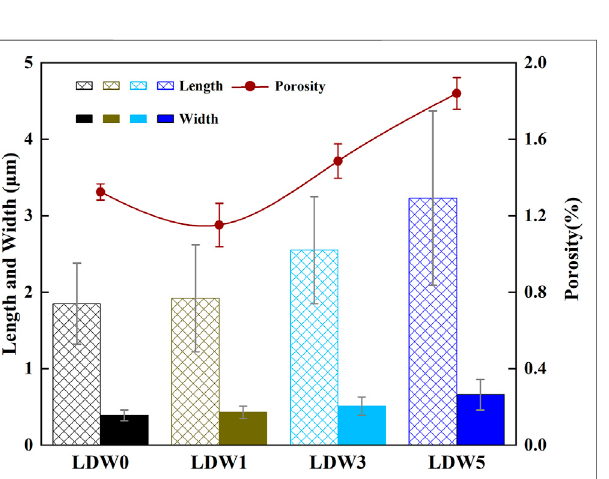
Frontiers in Materials |